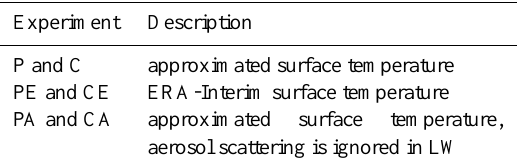
Table 1. Deviations from the default setup of the experiments con- ducted for the Solar Village case.